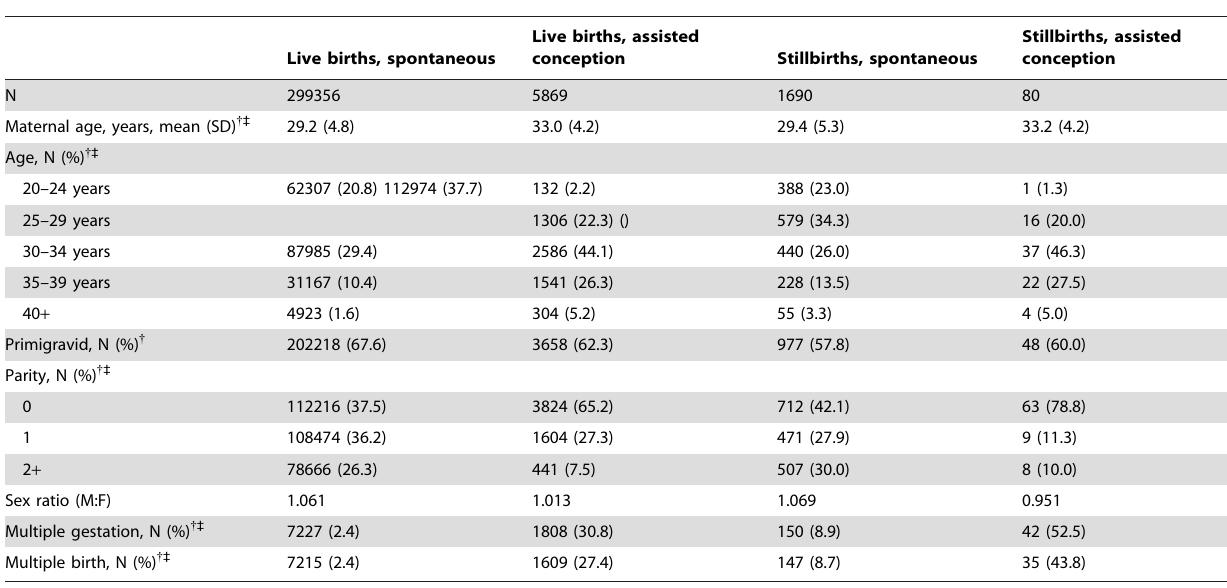
Table 1. Characteristics of live births and stillbirths by mode of conception.